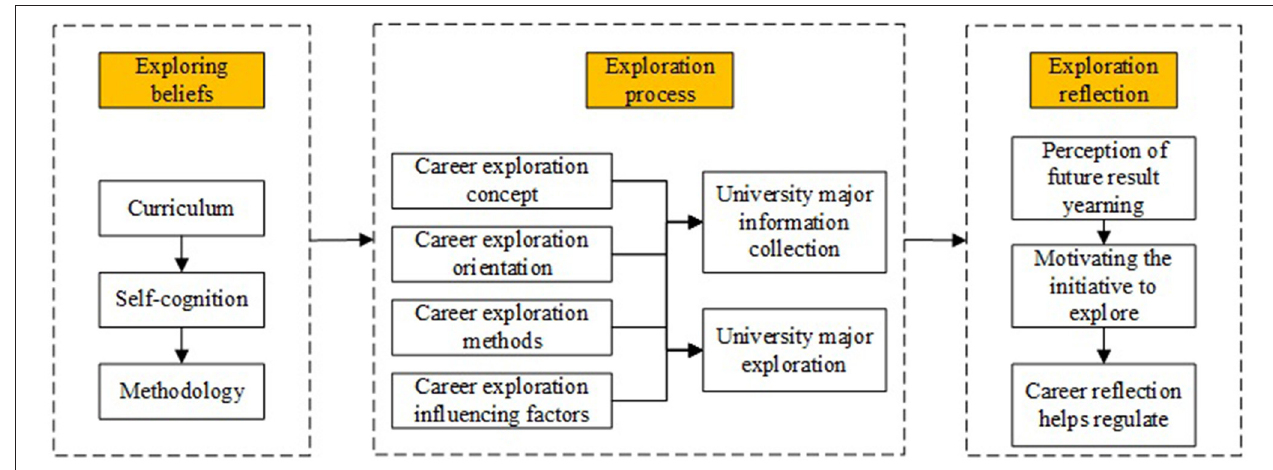
FIGURE 2 | Coping model of career exploration for high school